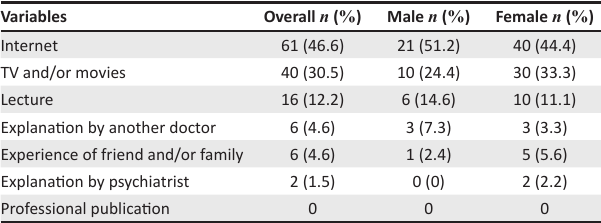
TABLE 1: Main source of knowledge of electroconvulsive